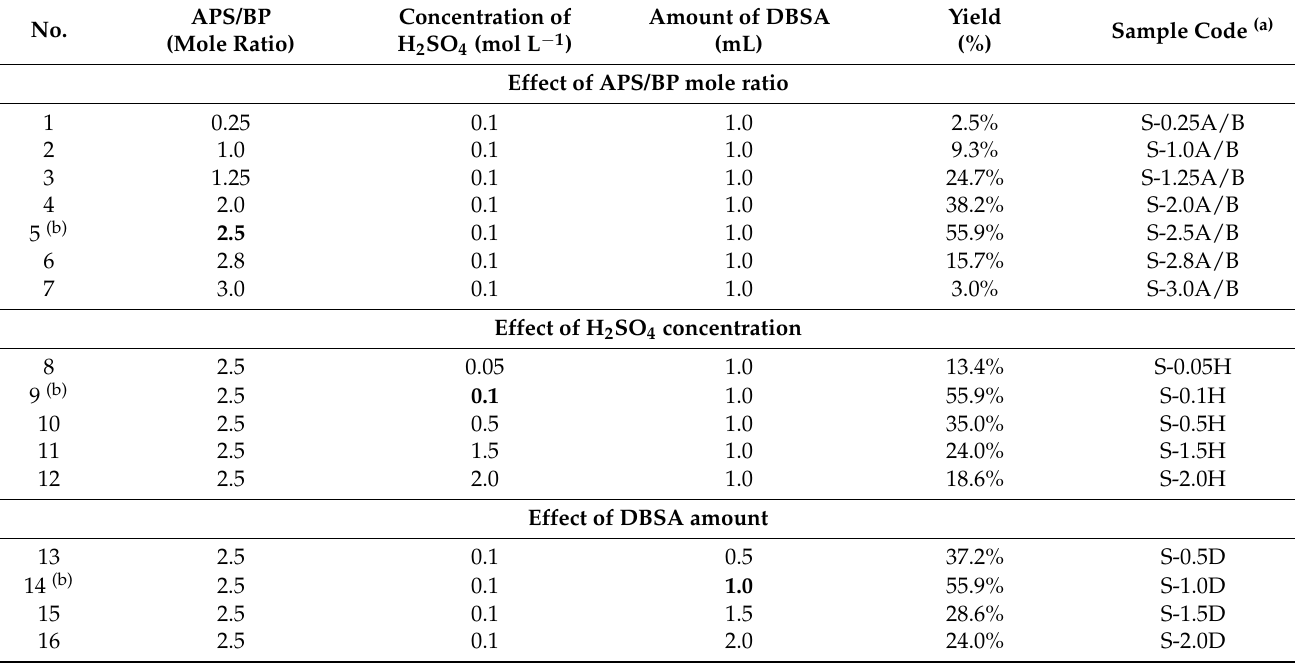
Table 1. Details of Pbp preparation by chemical oxidative polymerization under various reaction parameters and their sample